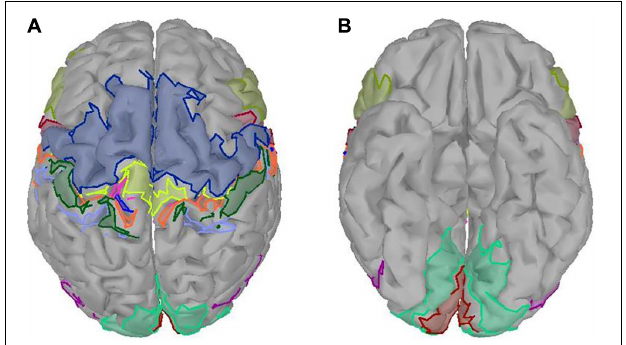
FIGURE 2 | Twenty-four ROIs defined by an atlas of a subset of the Brodmann areas. Different colored regions referred to different ROIs. (A) Top view. (B) Bottom